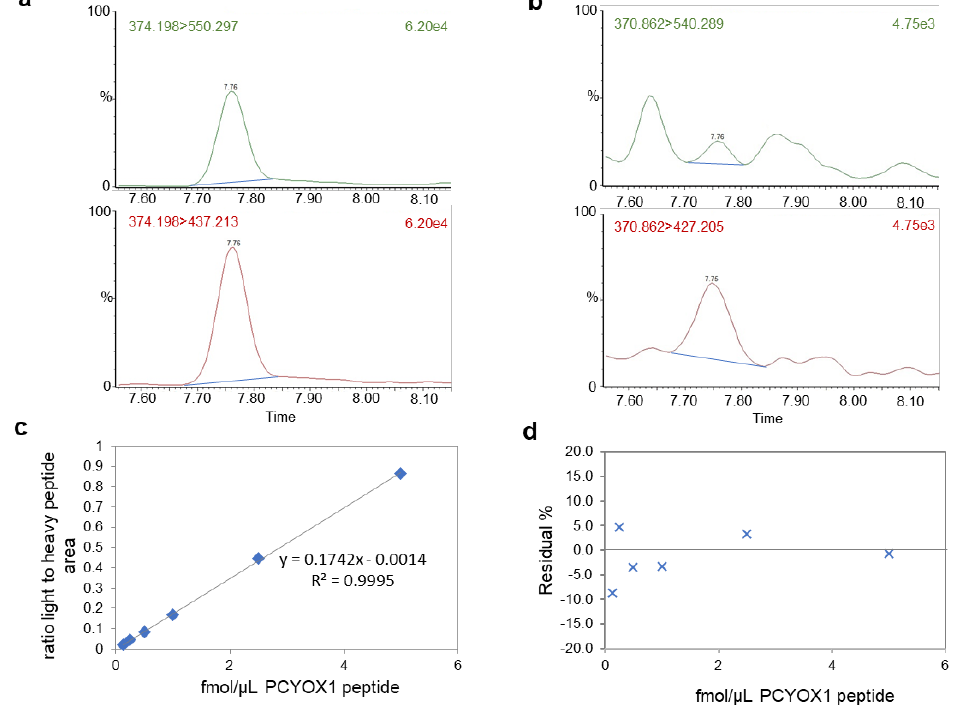
Figure 5. Analysis of the PCYOX1 protein in platelets from WT mice by mass spectrometry with a multiple reaction monitoring approach. Representative images of the chromatogram of the transitions of the heavy peptide ( a ) and the endogenous proteotipic peptide of PCYOX1 ( b ). ( c ) Standard curve generated with increasing concentrations of light peptide (0.125–5 fmol/ µ L) and fixed concentration of heavy peptide (5 fmol/ µ L). Data are expressed as the ratio of light peptide area versus heavy peptide area. The equation and the R 2 value are reported. ( d ) Relative residual error in the extrapolation of light peptide concentration expressed as % of the expected peptide concentration. The PCYOX1 content was then normalized for total protein content measured by label-free mass spectrometry.